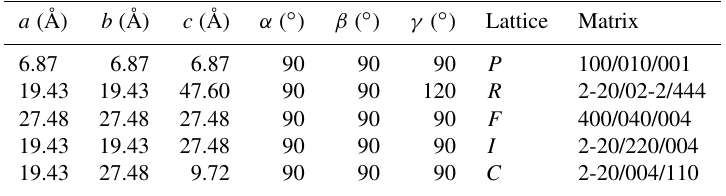
Table 2. Different possible unit cells, as derived from the X-ray diffraction patterns of tancaite-(Ce). In the first row, the subcell common to all the patterns is reported; in the last column the transformation matrices, which related the different unit cells to the common subcell, are listed. For the possible real symmetry of tancaite-(Ce), see the text.